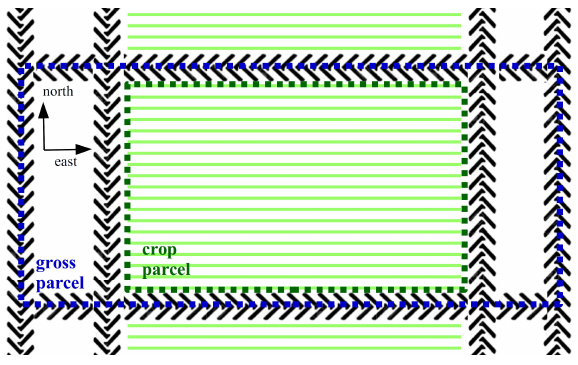
Figure 2. Sketch of the gross and crop parcel structure and its alignment. Each crop parcel was seeded with 19 rows of winter wheat. The tire tracks separate the crop parcels and allow vehicles to access the winter wheat to provide